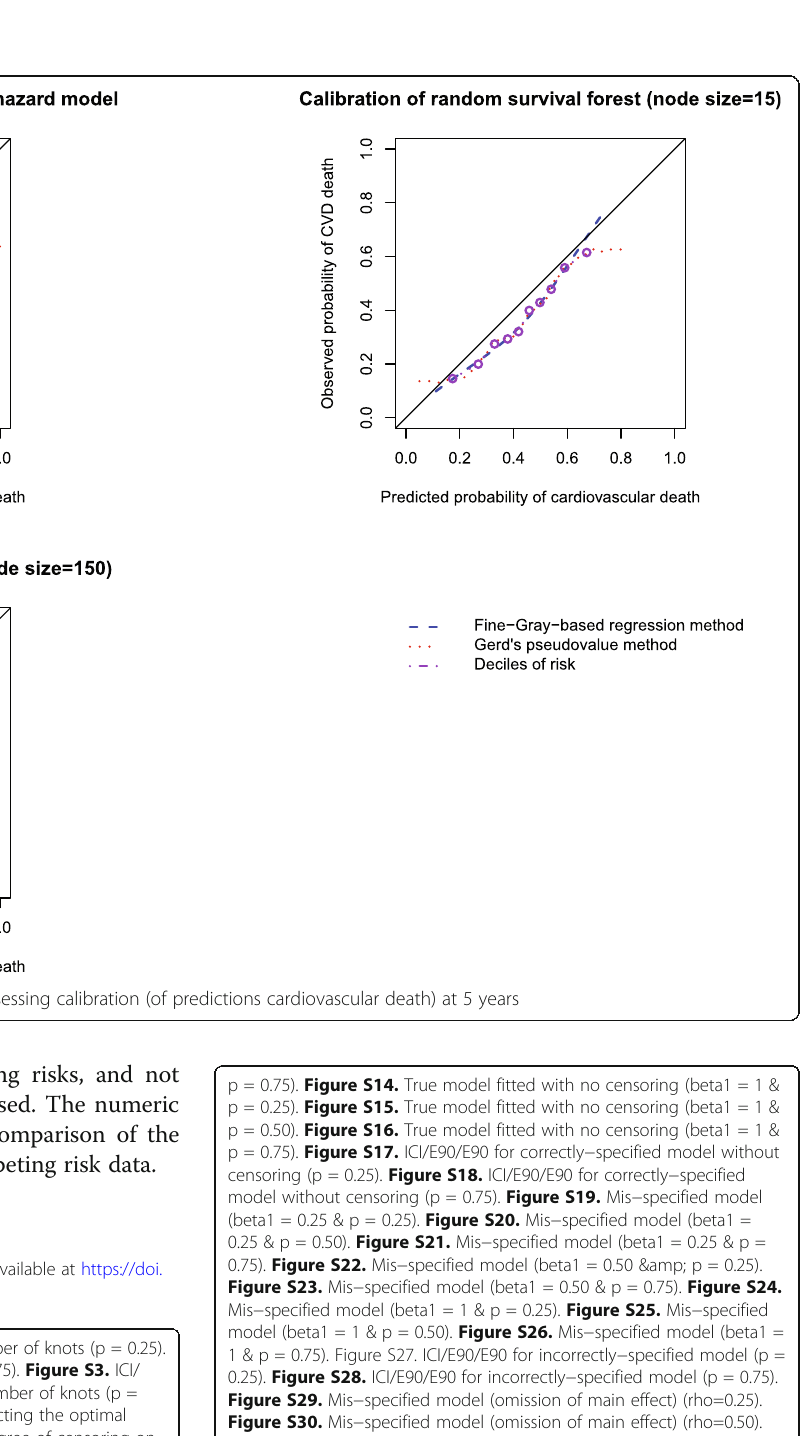
Figure S29. Mis − specified model (omission of main effect) (rho=0.25). Figure S30. Mis − specified model (omission of main effect) (rho=0.50). Figure S31. Mis − specified model (omission of main effect) (rho=0.75). :R code for constructing calibration curves and numerical metrics of calibration using restricted cubic